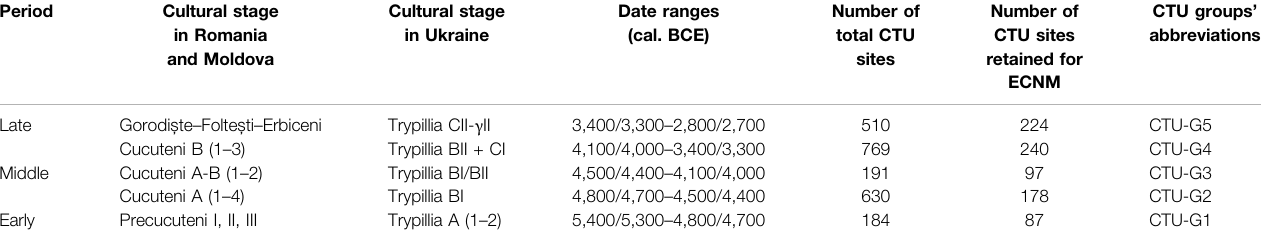
TABLE 1 | Cucuteni – Trypillia Unity (CTU) chronology during the Eneolithic in Eastern Europe (after Mantu, 1998; Shukurov et al., 2015), number of total archaeological sites per cultural stage, and number of sites retained to run the ECNM and CTU groups ’ abbreviations used in this study.